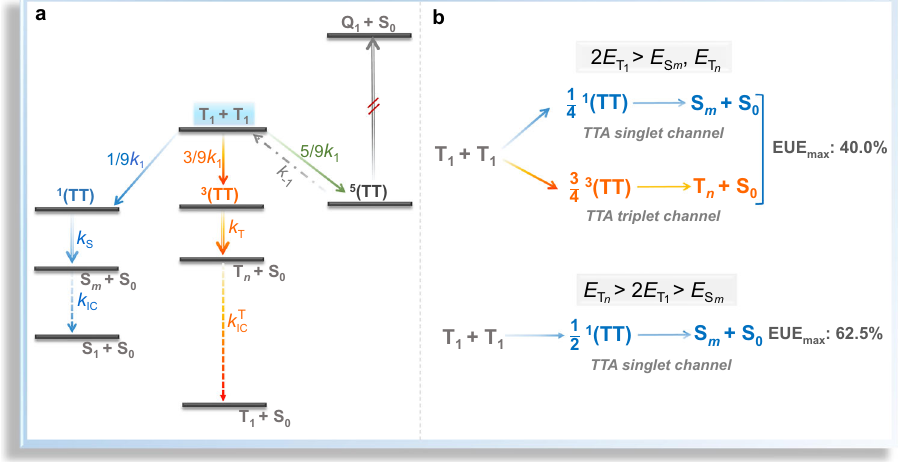
Fig. 1 | TTA mechanism and EUE max of the general TTA model. a Energy-level diagram illustrating the mechanism of TTA. b EUE max of the general TTA model with its triplet channel opened or closed, respectively. 1 (TT), 3 (TT), and 5 (TT) are singlet-, triplet-, and quintet-featured intermediate states, respec- tively; S 1 , T 1 , and S 0 are the lowest excited singlet state, the lowest excited triplet state and ground state, respectively; S m and T n are higher-lying singlet